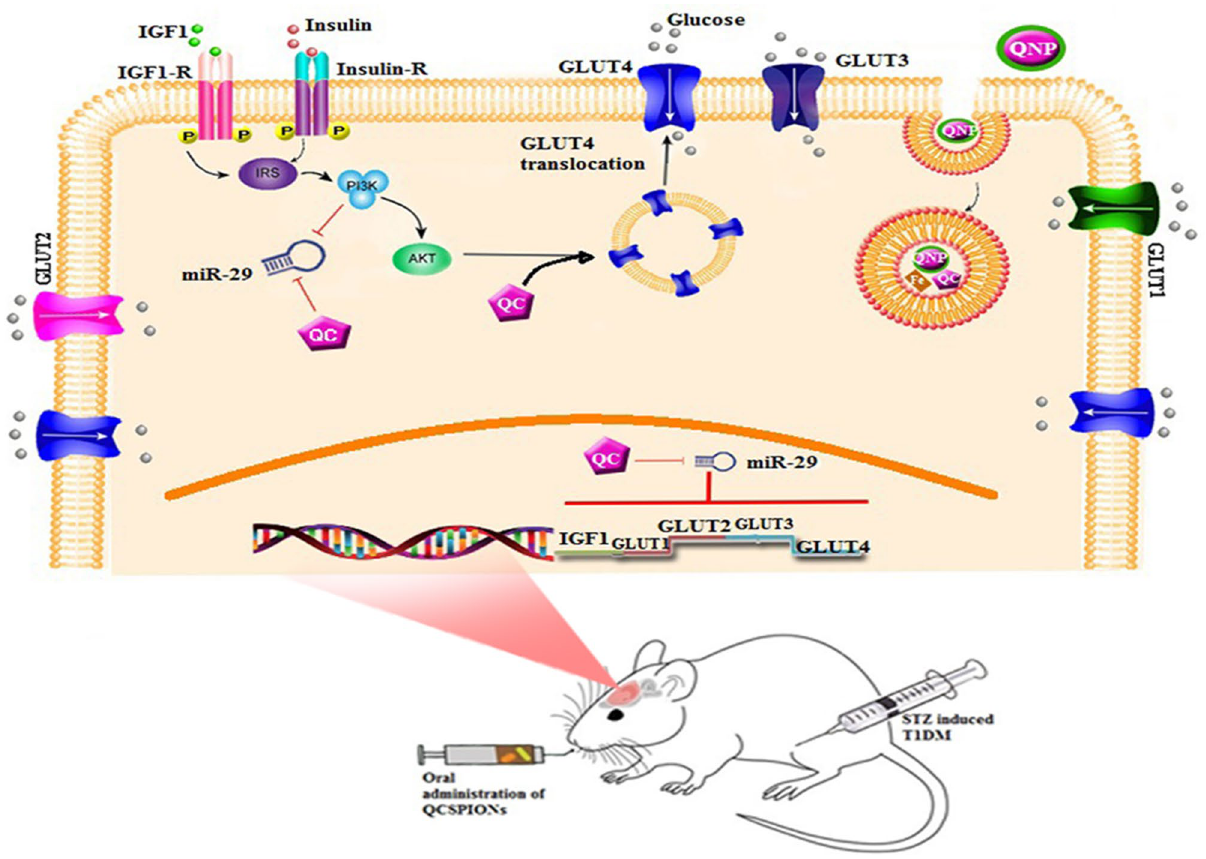
Figure 5. Schematic image of the protective effect of QC after released from superparamagnetic iron oxide nanoparticles on metabolism-related genes and miR-29 family in the hippocampus of streptozotocin-induced diabetic rats. This Figure was drew by Mansoureh Zakeri using powerPoint and